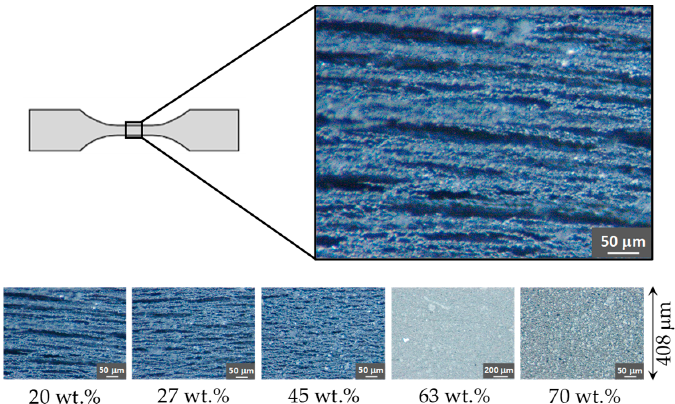
Figure 6. Illustration of carbonyl iron micro-particles (CIPs) inside the tensile test specimens for different particle concentrations, the material samples with 20, 27 and 45 wt % of carbonyl microparticles content have an alignment parallel to the longitudinal sample direction. For material samples with 63 and 70 wt % of CIPs microparticles content, the particles are not aligned. This is because of the viscosity of the uncured polymer, mixed with the magnetic microparticles, increases significantly for material samples with 63 and 70 wt % of CIPs, and the magnetic force field applied during the polymer curing process is not strong enough to produce any particle arrangement.